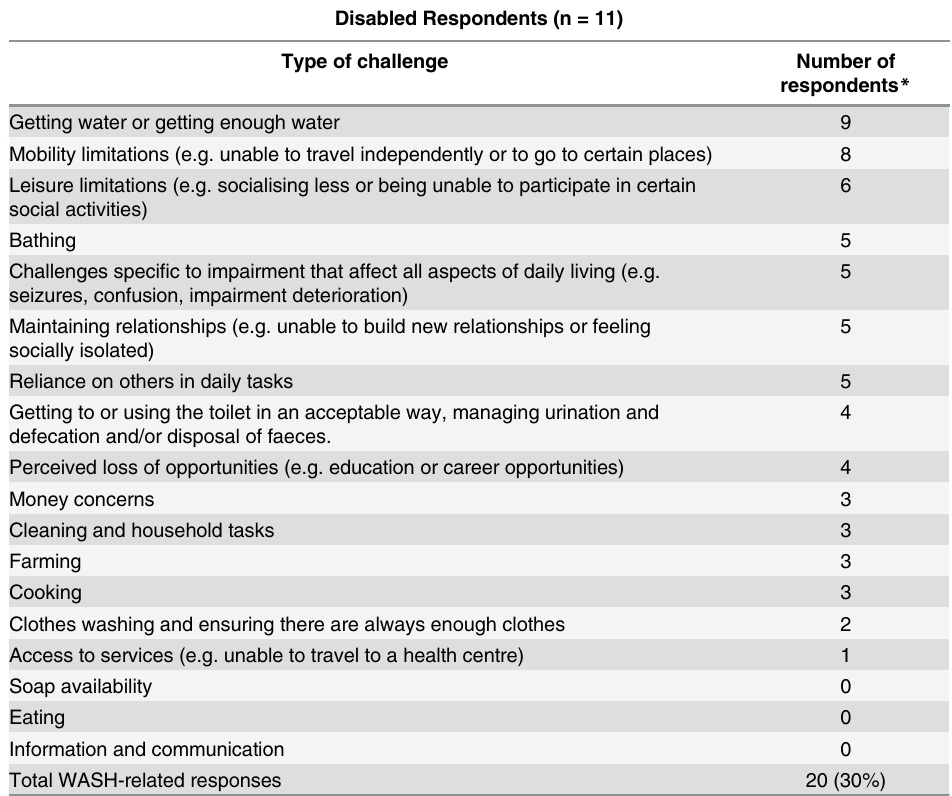
Table 4. Number of disabled respondents experiencing each of the daily